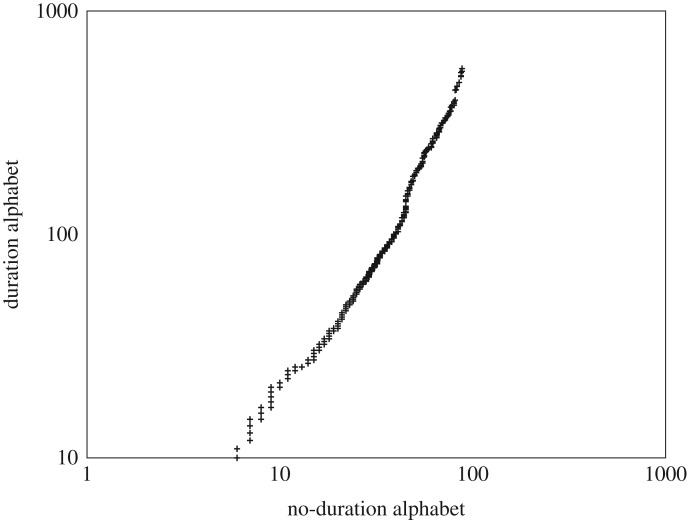
A comparison of the two alphabets, with and without note duration as log−log showing their clear linear power-law relationship. Each of the 883 data points corresponds to the size of the duration alphabet plotted against that of the no-duration alphabet for a single composition.